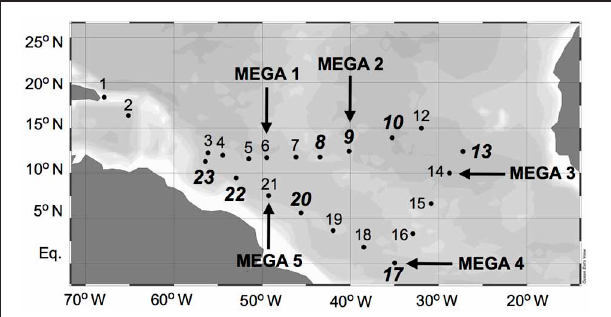
FIGURE 1 | Cruise track of SJ0609 aboard R/V Seward Johnson in September 2006. Diel nifH expression is reported from stations italicized in bold. MEGA nutrient addition experiments were performed at stations designated with